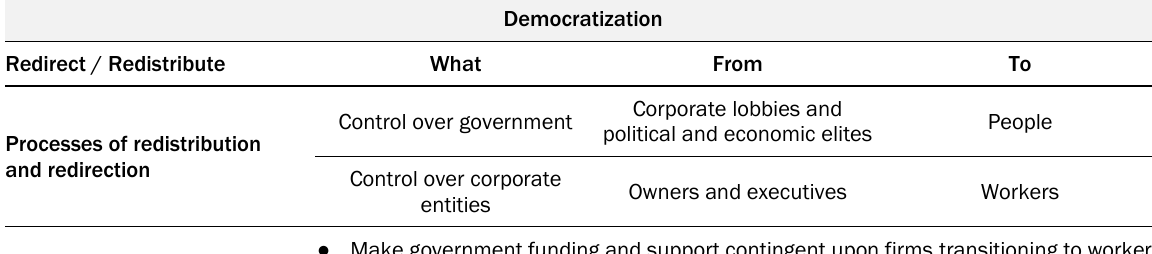
Table 4. Examples of Redistributive Policies for Democratization